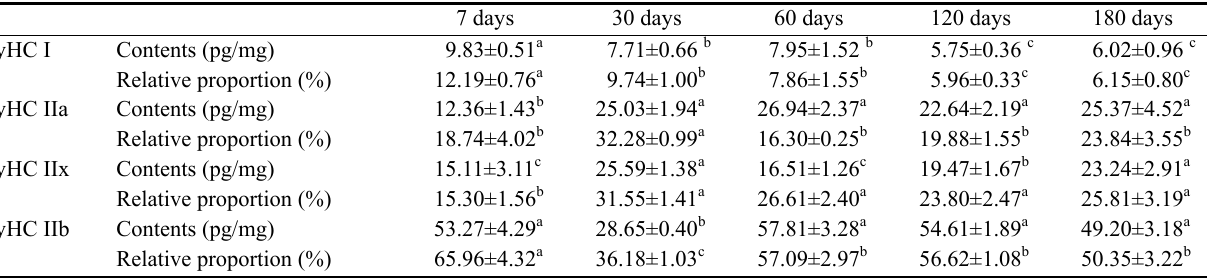
Table 1. Comparison of MyHC protein expression in LM of pigs with different postnatal